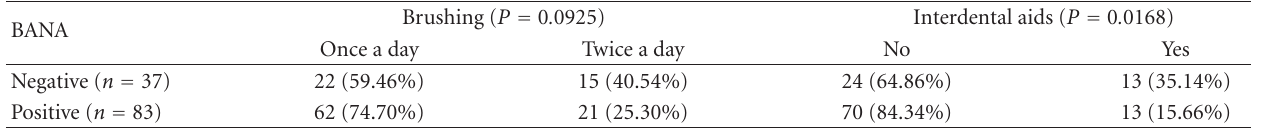
Table 3: BANA relative to oral hygiene practices.